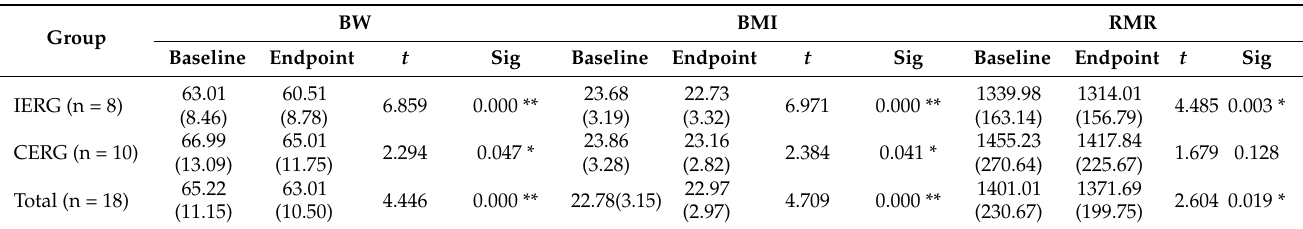
Table 2. Results of the paired t test of the difference in bodyweight, BMI, and RMR within each group.